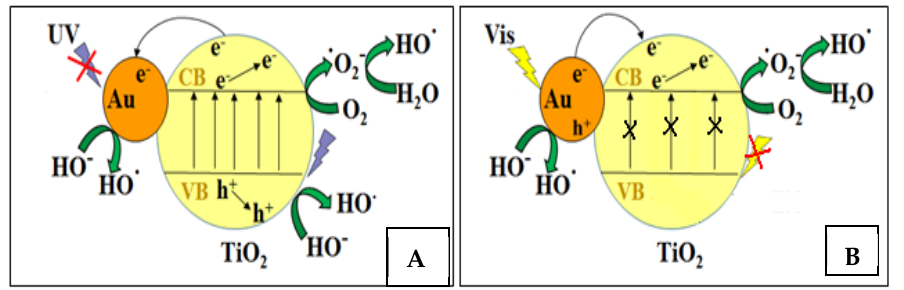
Figure 11. Schematic representation of the proposed mechanism for photocatalytic degradation of AMX under UV ( A ) and visible light irradiation ( B ).